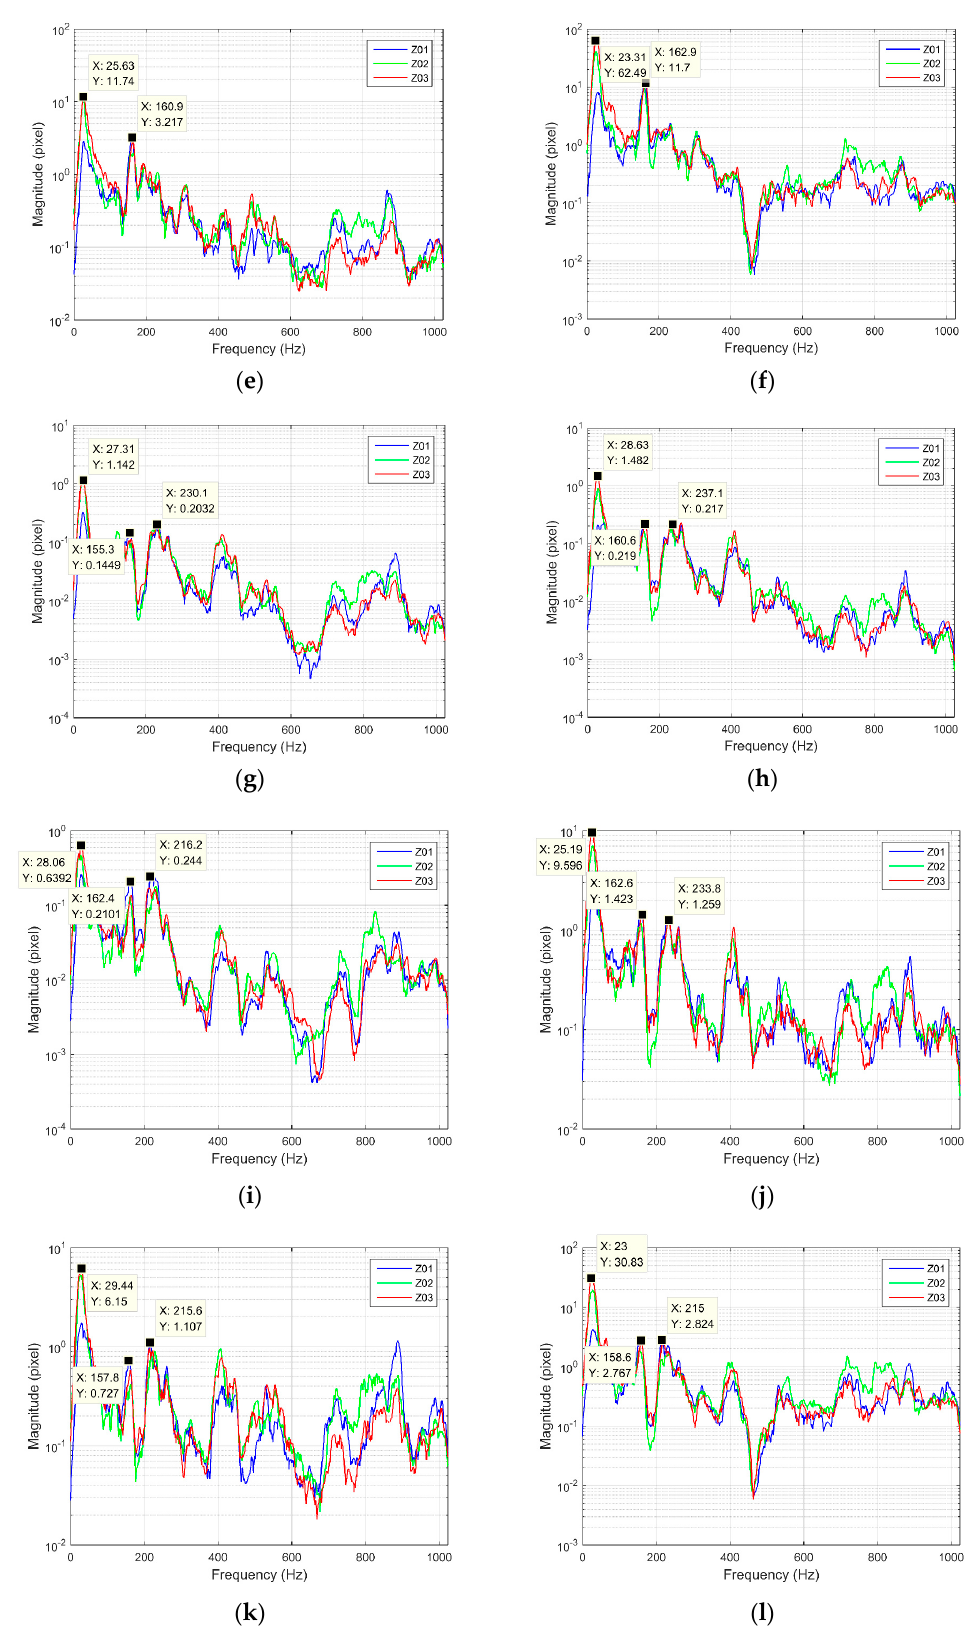
Figure 12. The FRF was obtained by di ff erent RWAs. ( a ) H 11 ; ( b ) H 12 ; ( c ) H 13 ; ( d ) H 14 ; ( e ) H 15 ; ( f ) H 16